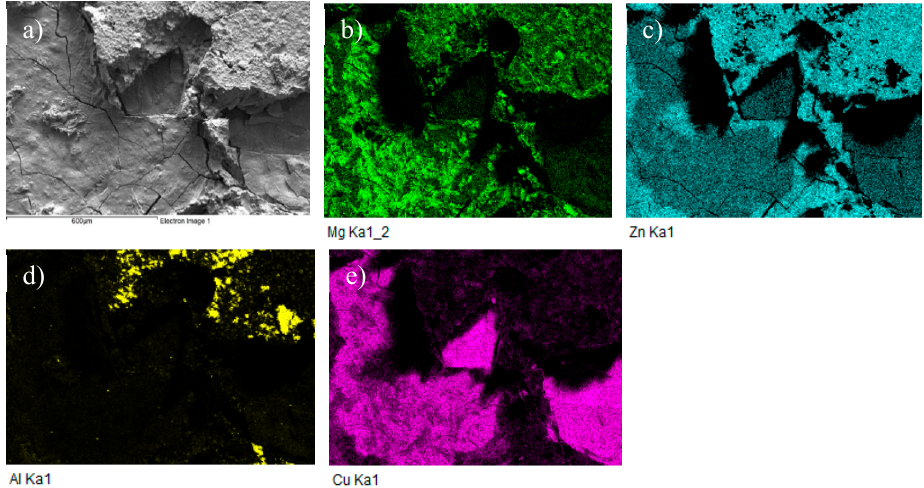
Figure 22. Fractured surface of soldered AlN/Zn5Al3Mg/Cu joint and the planar distribution of individual elements ( a ) fracture structure; ( b ) Mg; ( c ) Zn; ( d ) Al; ( e ) Cu.